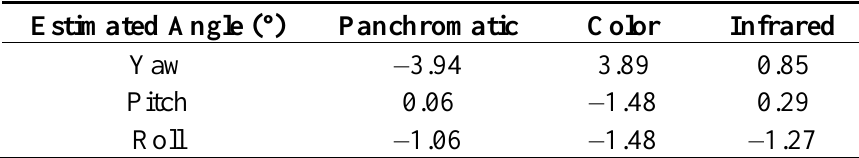
Table 3. Estimated cameras attitude